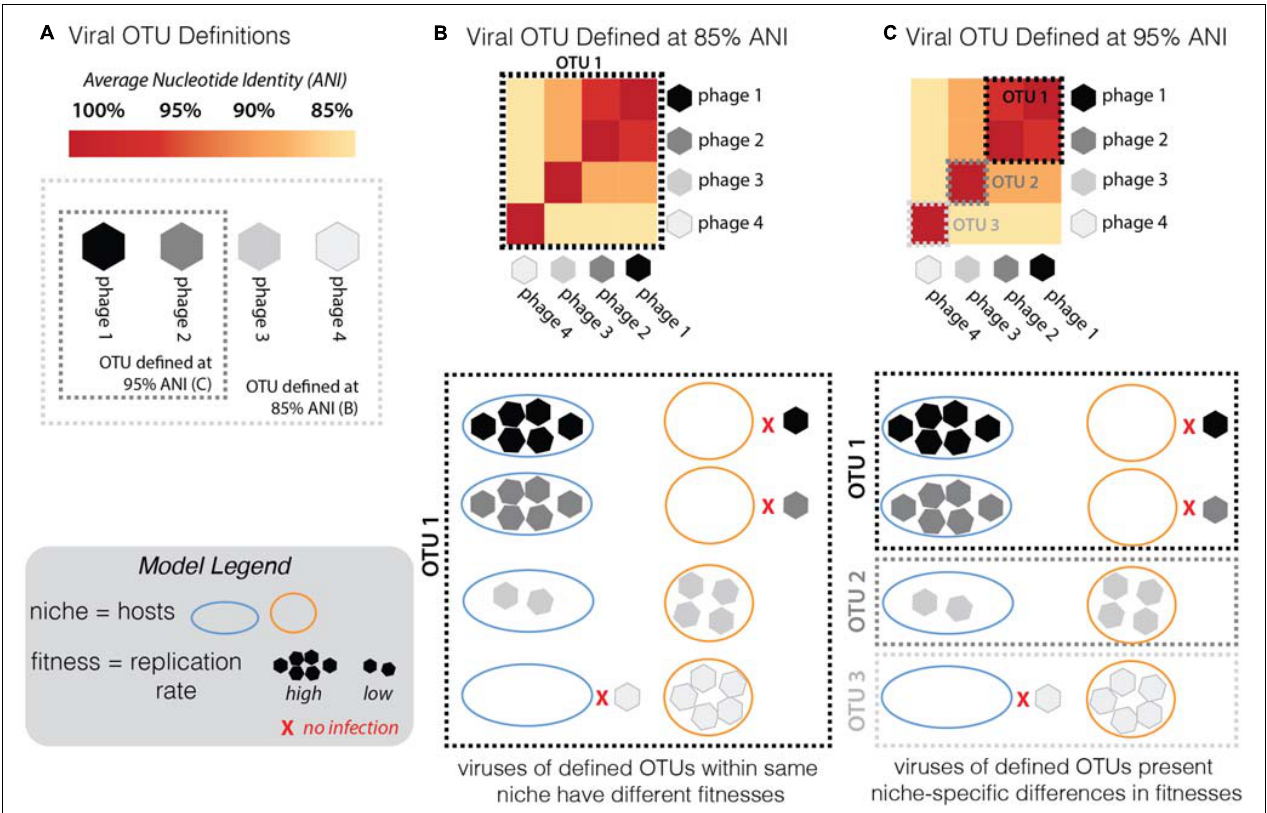
FIGURE 7 | Conceptual model of the framework used here to assess the validity of the current working definition of a phage population, or “phage OTU.” (A) For a group of phages along a continuum of genome similarity (measured by average nucleotide identity, ANI) from 85 to 95%, we contrast the scenario whereby the phage OTU is defined at 85% (light gray dashed box) with the scenario when it is defined at 95% ANI (dark gray dashed box). To test the validity of these arbitrary groupings in establishing an effective definition for a phage OTU, one must consider fitness differences (measured by replication rates; see Model Legend) in different niches (hosts: “host 1” depicted by blue outline, “host 2” by orange; inability to infect is depicted by red “x”; see Model Legend). (B) Given the infection outcomes of the phages in this OTU 1 (defined by 85% ANI), there is no ecological cohesiveness. Phages in this OTU have different fitness outcomes (ranging from no infection to high reproduction rate on both hosts). (C) By redefining the phage OTU at 95% ANI, this same group of phages now falls into three distinct OTUs. Now the same infection traits observed by the distinct OTUs fall into ecologically cohesive patterns. Within each OTU, phages infect the same hosts with similar